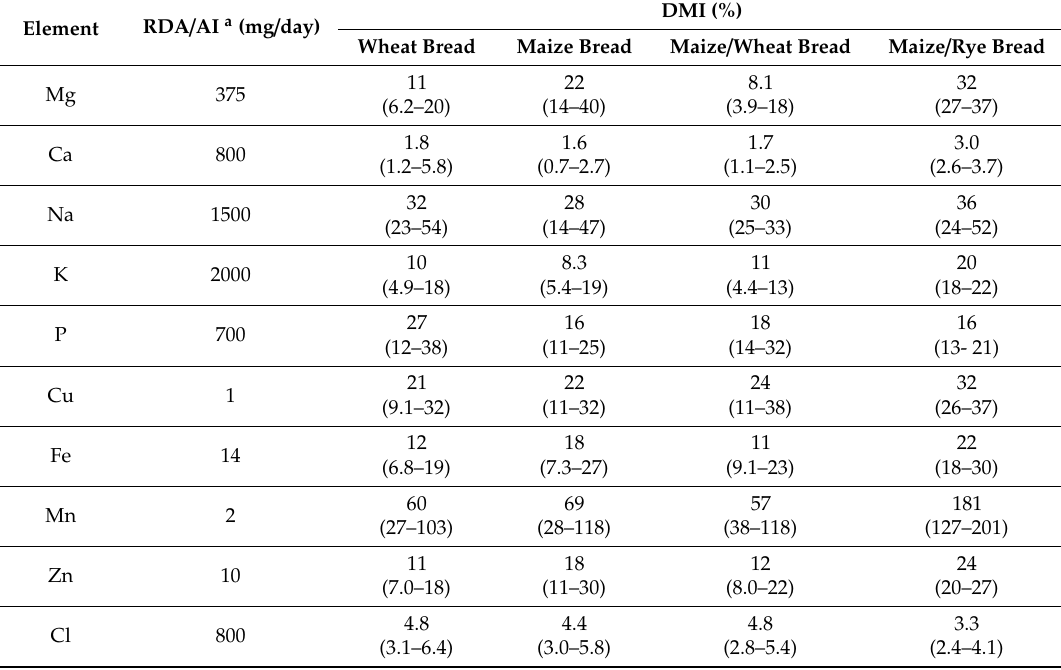
Table 2. Recommended daily allowance (RDA; mg / day) / adequate intake (AI; mg / day) and estimated daily mineral intake (DMI, %) of each element for the consumption of 100 g of